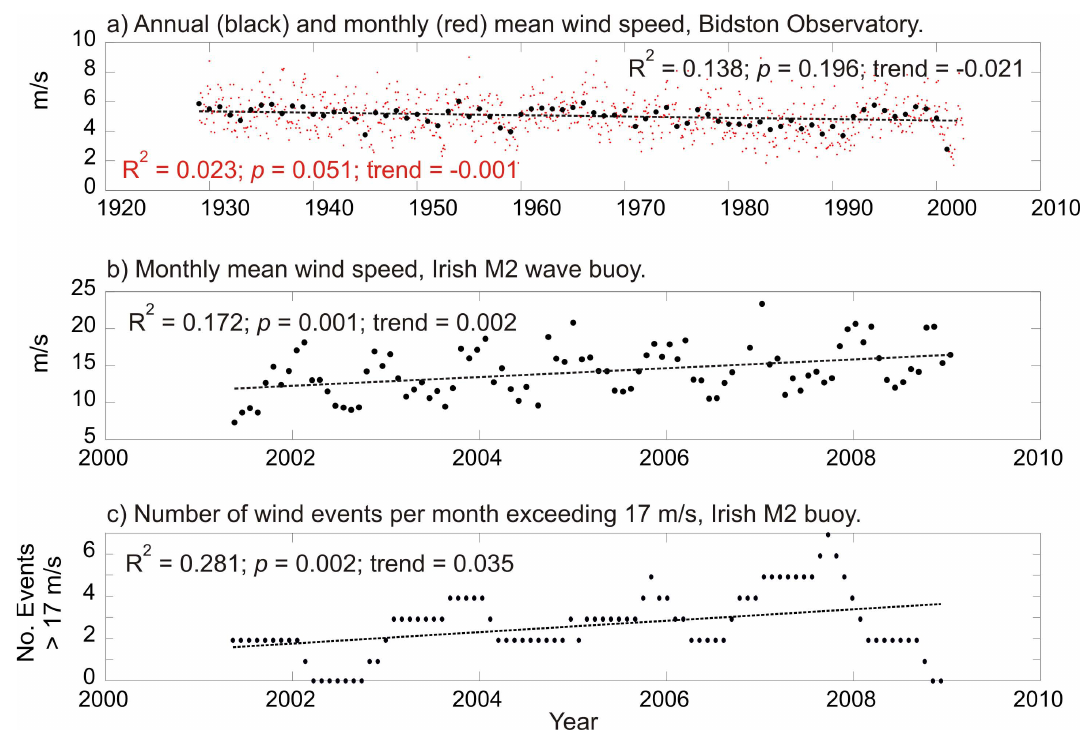
Fig. 2. Examples of the statistically significant results: (a) monthly (red) and annual (black) mean wind speeds from Bidston Observatory (1929 to 2002); (b) monthly mean wind speeds from M2 Irish wave buoy; and (c) number of events per month showing mean wind speeds > 17ms − 1 from M2 Irish wave buoy. Dashed lines indicate respective linear